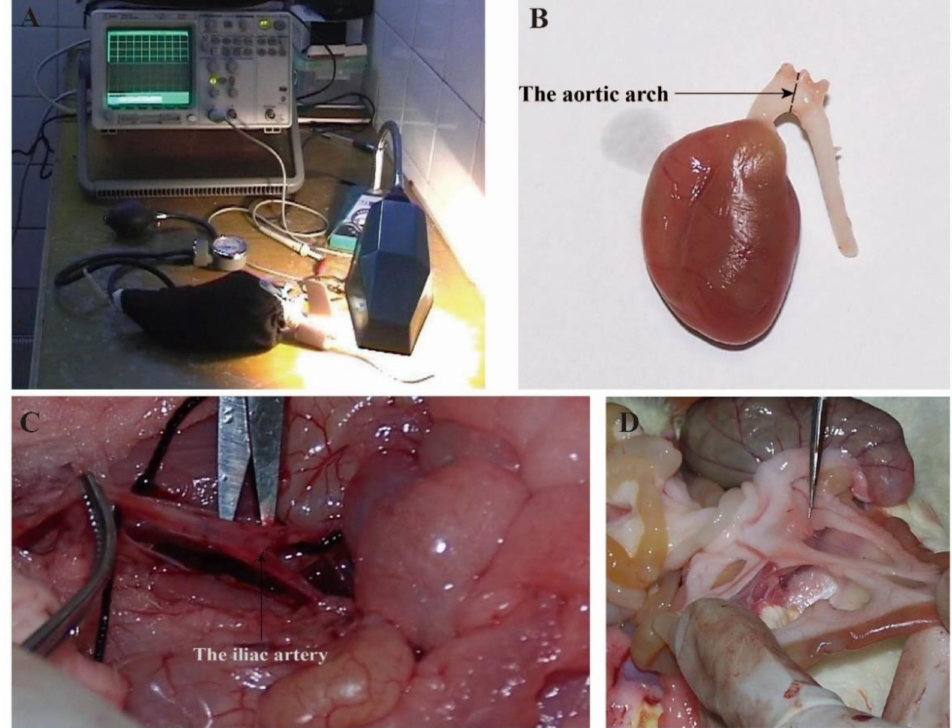
Figure 1. Taking Samples. ( A ) Measuring systolic blood pressure of the caudal artery in rats; ( B ) physical images of the aortic arch; ( C ) physical images of the iliac artery; ( D ) physical images of the branch of mesenteric